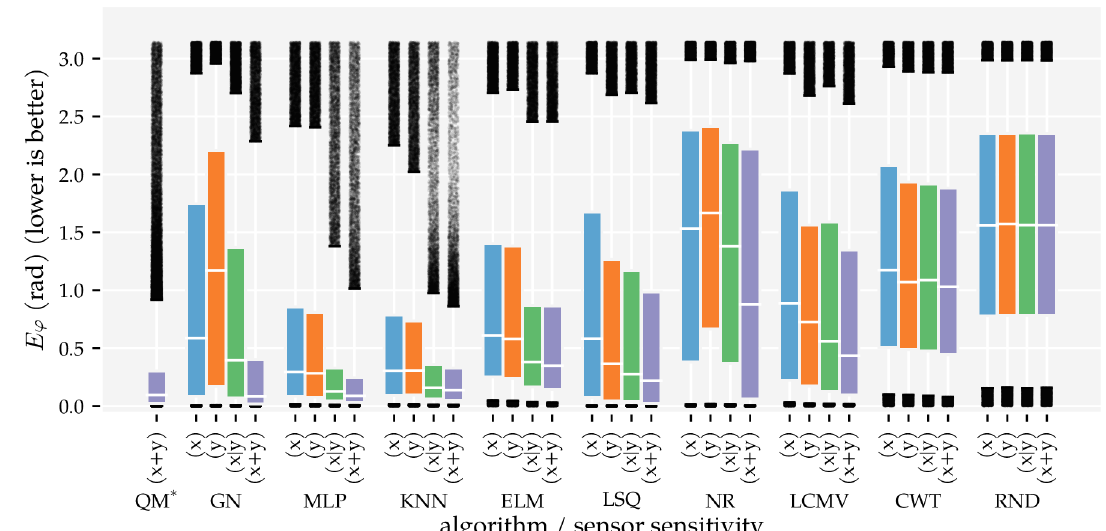
Figure 12. Boxplots of the movement direction error distributions for all algorithms in the second analysis method. This analysis varied the sensitivity axes of the sensors: (x + y) measured both velocity components at all sensors, (x|y) alternated measuring v x and v y for subsequent sensors, (x) measured only v x at all sensors, (y) measured only v y at all sensors. The D s = 0.01 training and optimisation set and σ = 1.0 × 10 − 5 ms − 1 noise level were used. The whiskers of the boxplots indicate the 5th and 95th percentiles of the distributions. Predictions with errors outside these percentiles are shown individually. QM* is based on the D s = 0.01 condition in Analysis Method